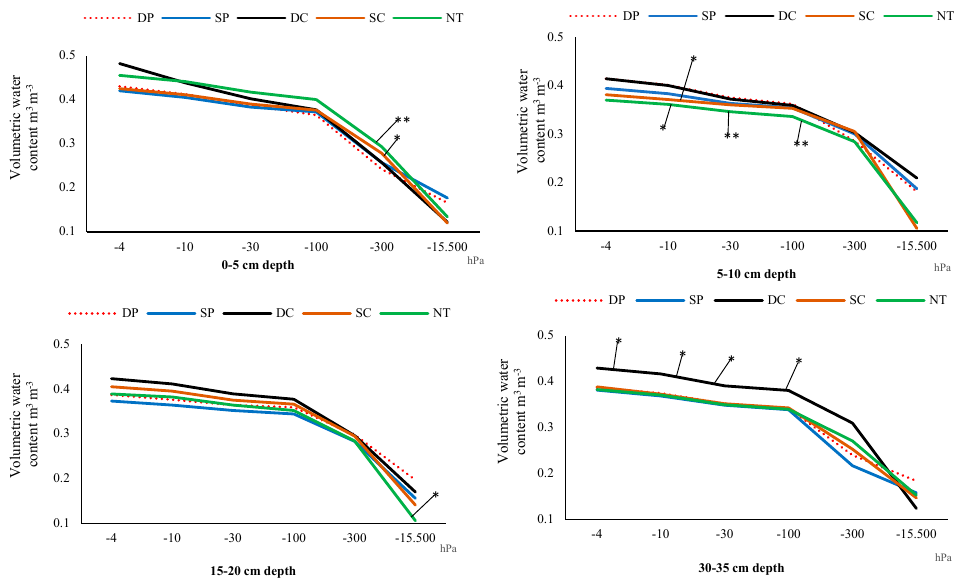
Figure 6. Effect of tillage intensity on soil water retention capacity in different soil layers, 2019. Notes: DP—deep ploughing (control treatment); SP—shallow ploughing; DC—deep cultivation; SC—shallow cultivation; NT—no tillage (direct drilling). *—significant difference at 0.01 < p ≤ 0.05; **—at 0.001 < p ≤ 0.01. The significance of data was determined by Fisher’s least significant difference (LSD) test.